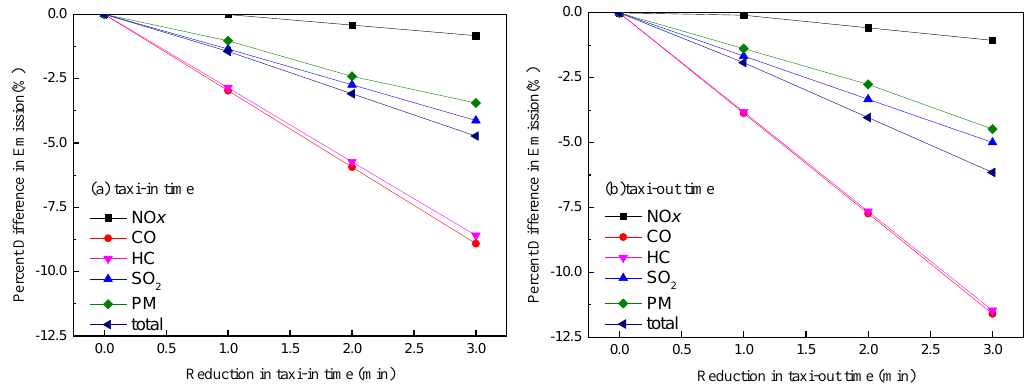
Figure 3. The relationships between the emission changes, ( a ) reductions in taxi-in time, and ( b ) reductions in taxi-out